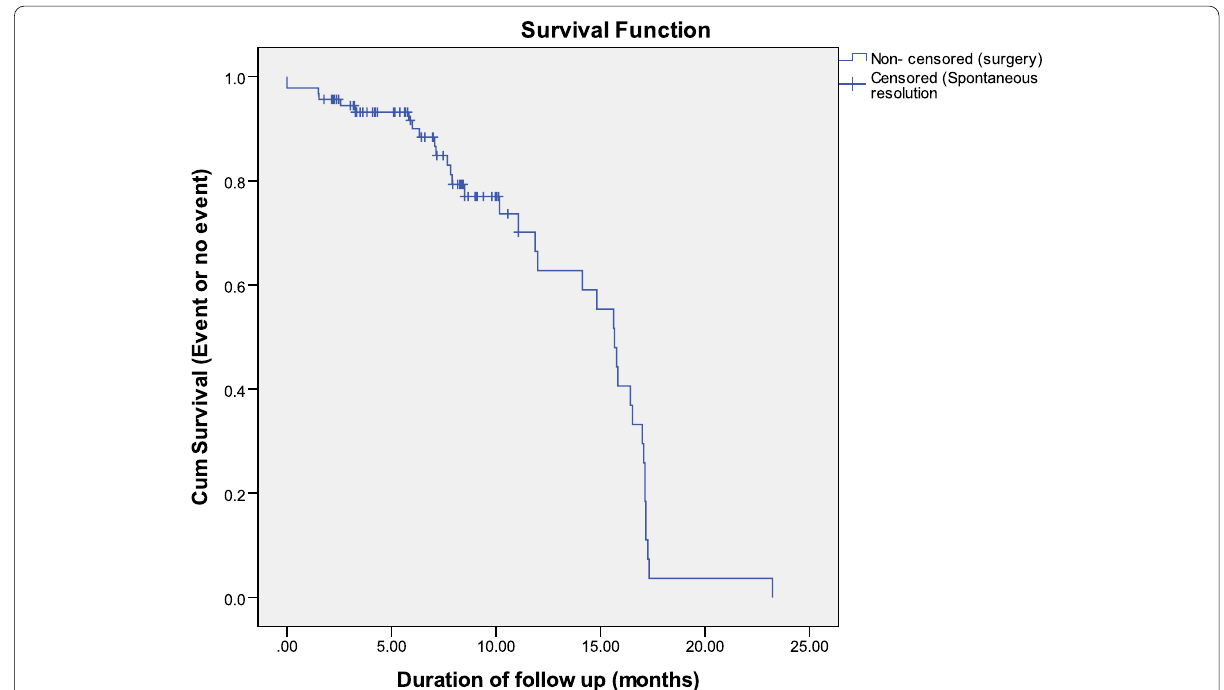
Fig. 1 Kaplan-Meyer curve for all patients illustrating time to event (surgery) and no event (spontaneous resolution) in the total cohort